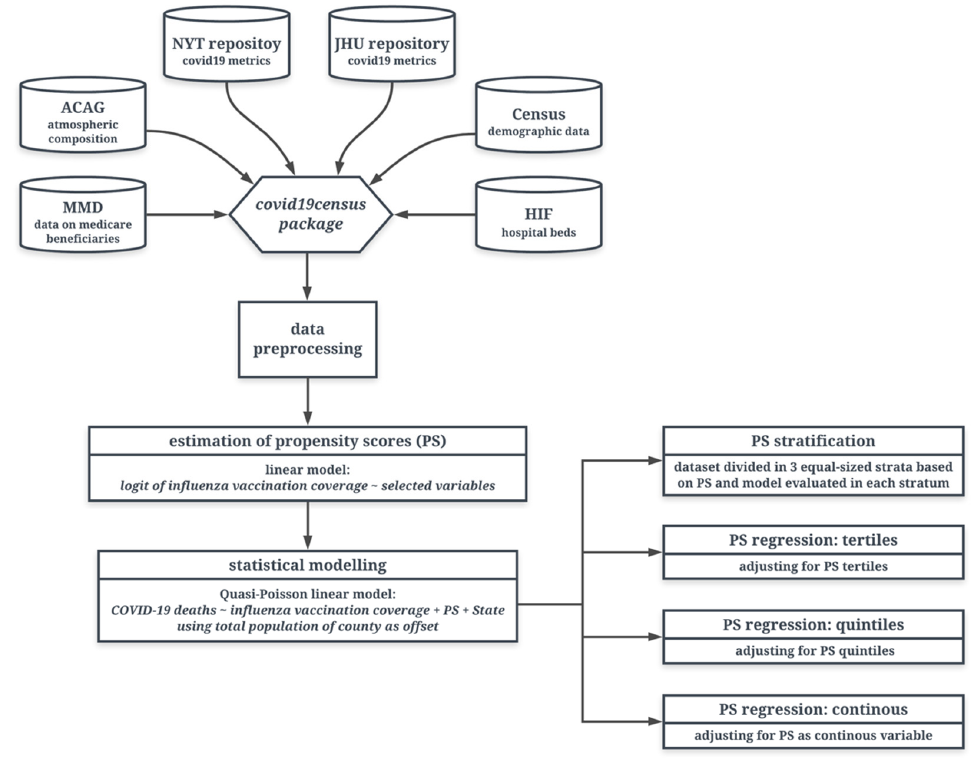
Figure 2. Steps used in this analysis, including data collection, preprocessing, and different propensity-score adjustment methods. COVID-19 data with other population and health characteristics were collected from six different sources and pooled into the COVID-19 census package. Counties meeting inclusion criteria were used in further analysis.